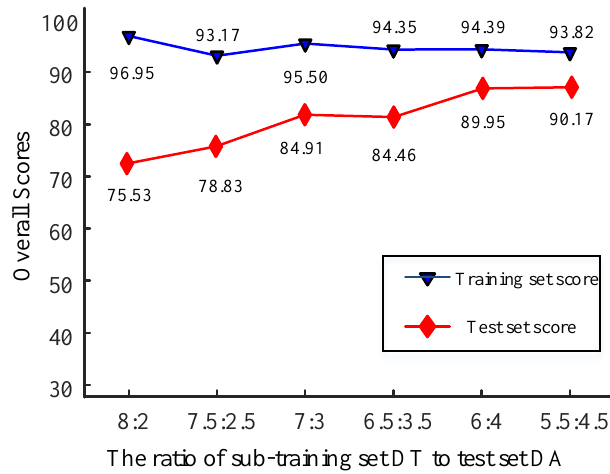
Figure A2. Score curve of the different ratio.